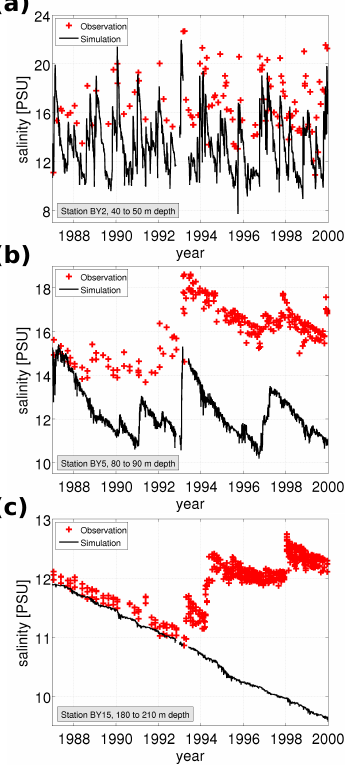
Figure 11. Near-bottom salinities at stations BY2, BY5 and BY15 Fig. 11. Near-bottom salinities at station BY2, BY5 and BY15 in panels (a) , (b) and (c) , respec- in panels (a) , (b) and (c) , respectively. The positions of the re- tively. The positions of the respective stations are indicated in Fig. 1. Observations are from spective stations are indicated in Fig. 1. Observations are from the the Swedish Oceanographic Data Centre at SMHI (SHARK). Swedish Oceanographic Data Centre at SMHI (SHARK).